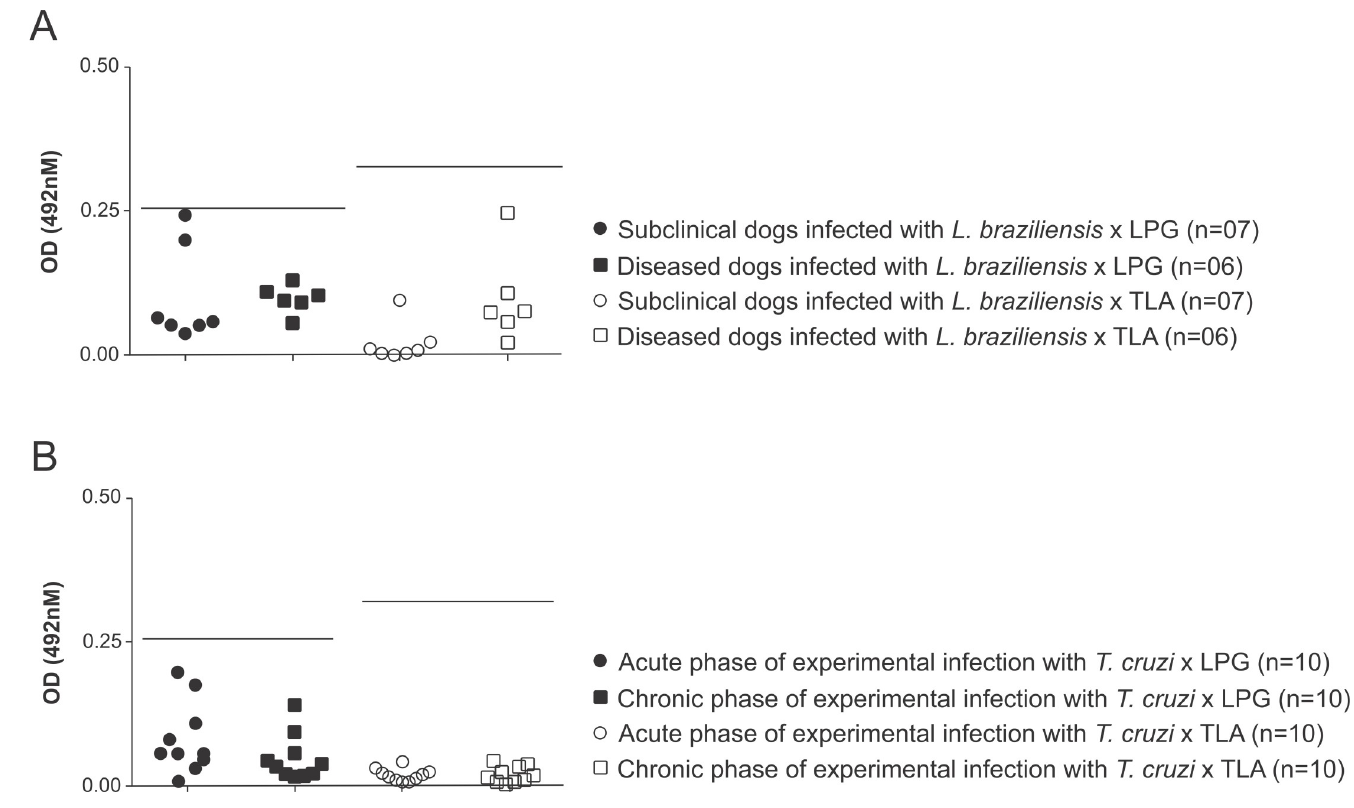
Fig 4. Evaluation of the occurrence of cross-reactivity using the LPG and TLA-ELISAs with samples from dogs infected with other trypanosomatids. Serum samples from (A) dogs infected with L . braziliensis (with or without clinical disease) and (B) from dogs experimentally inoculated with T . cruzi (chronic and acute phases of the infection) were individually tested. The lines within the graphs represent the cut-off of each